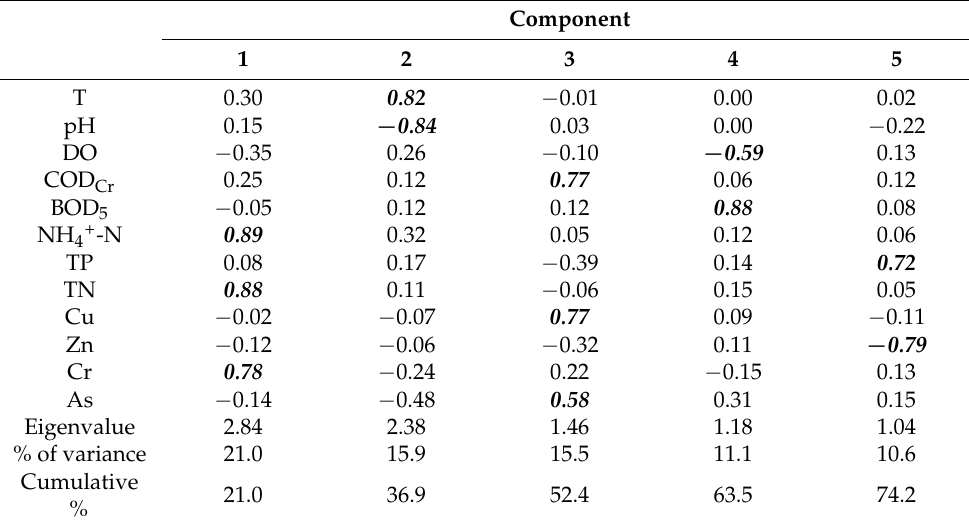
Table 4. Factor loading and variance values extracted using the varimax rotated factor analysis method for the Xiujiang